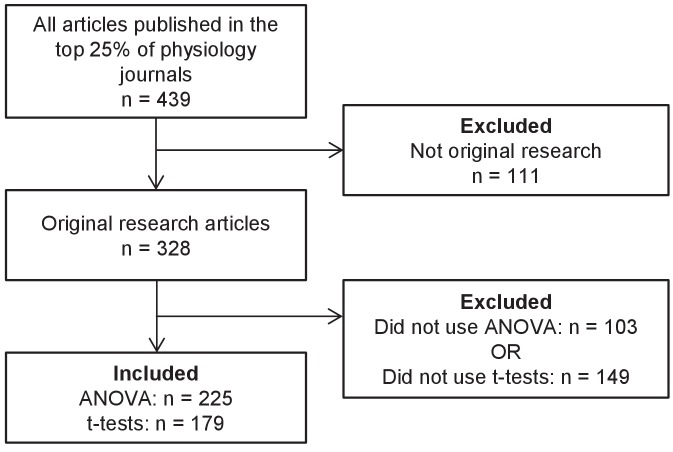
Systematic review flow chart.The flow chart illustrates the selection of articles for inclusion in this analysis at each stage of the screening process.10.7554/eLife.36163.003Figure 1—source data 1.Data from systematic review.